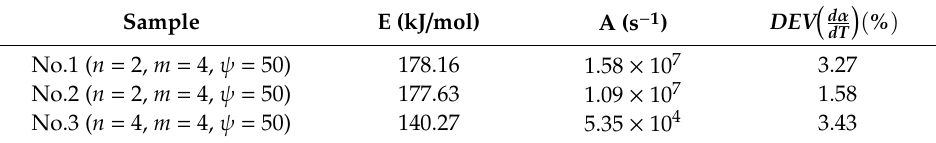
Table 2. The related parameters calculated for the multifaceted model.